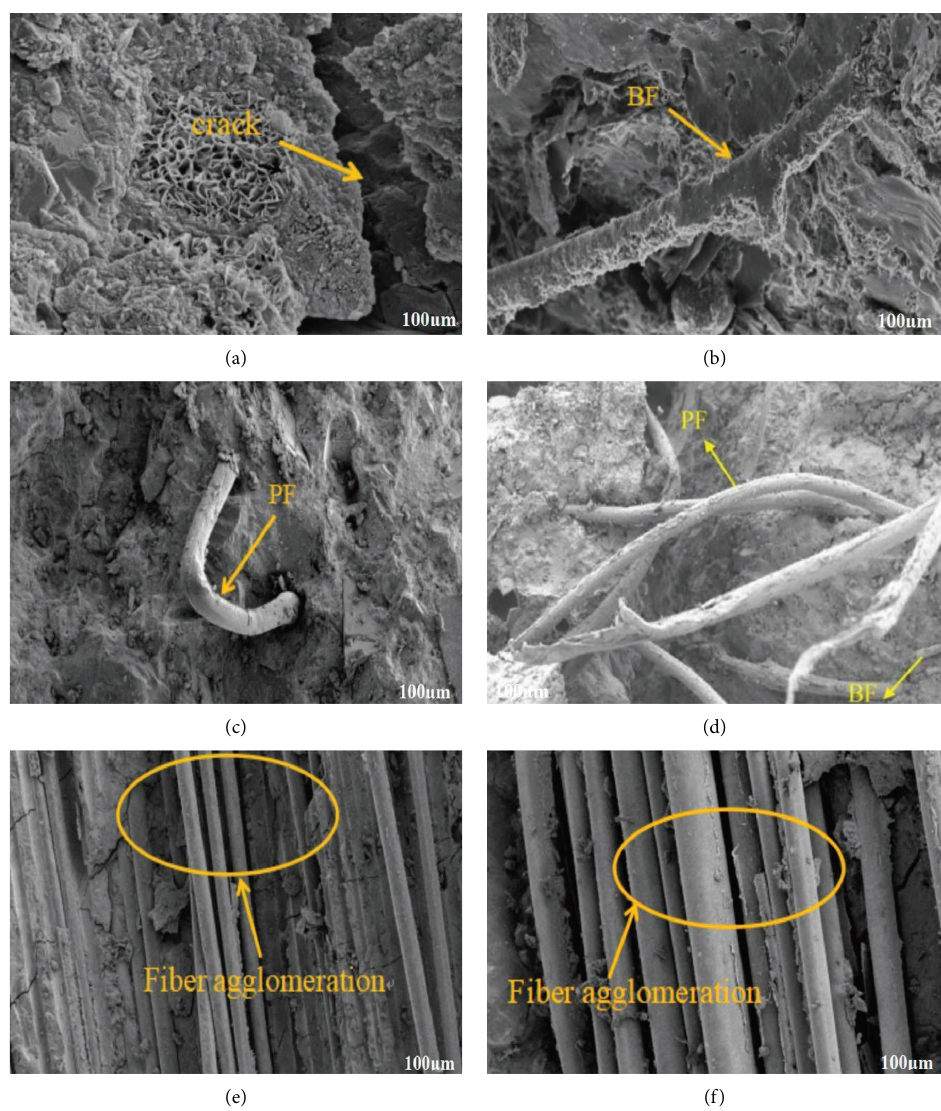
Figure 17: SEM microstructure. (a) OC group. (b) BF-0.1 group. (c) PF-0.1 group. (d) HC-0.2 group. (e) HC-0.3 group. (f) HC-0.4 group.